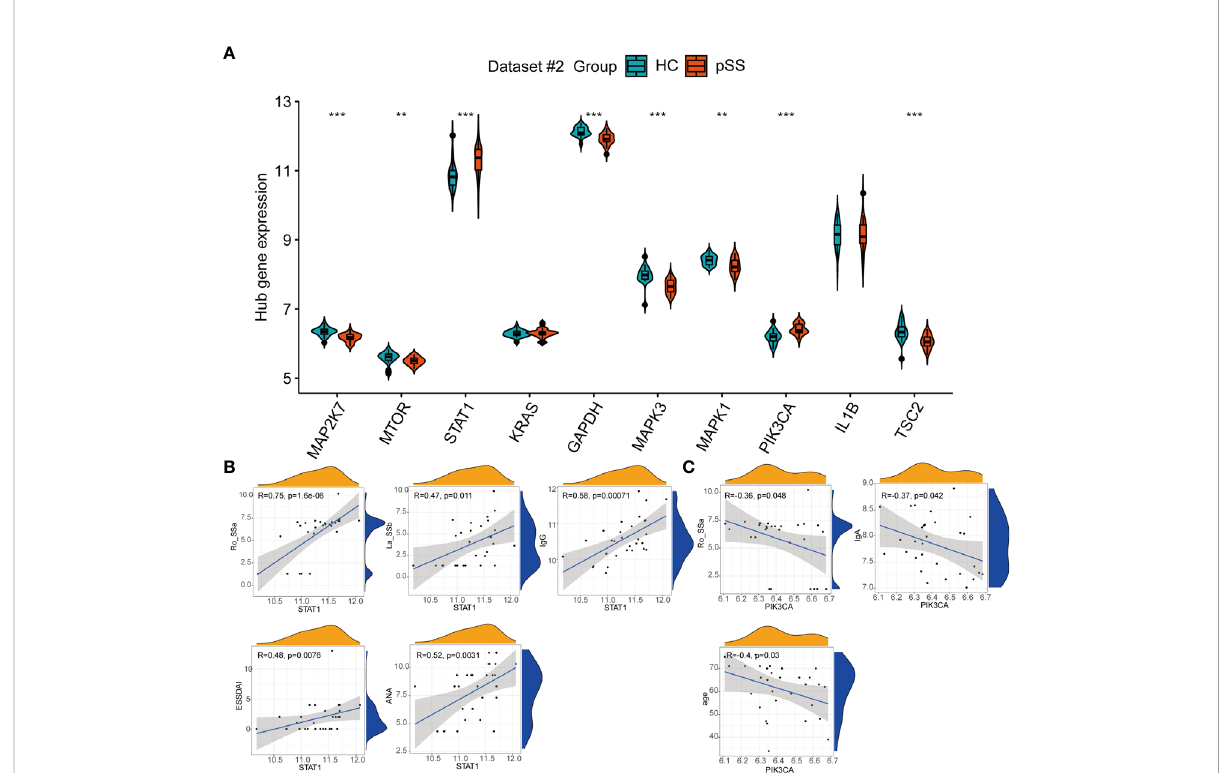
FIGURE 7 The expression of autophagy hub genes in pSS. (A) The violin plot illustrates the autophagy hub genes that are dysregulated between the HCs and pSS groups in dataset #2. (B) Correlations between STAT1 and laboratory tests in pSS patients in dataset #2. (C) Correlations between STAT1 and laboratory tests in pSS patients in dataset #2. **, p<0.01; ***,